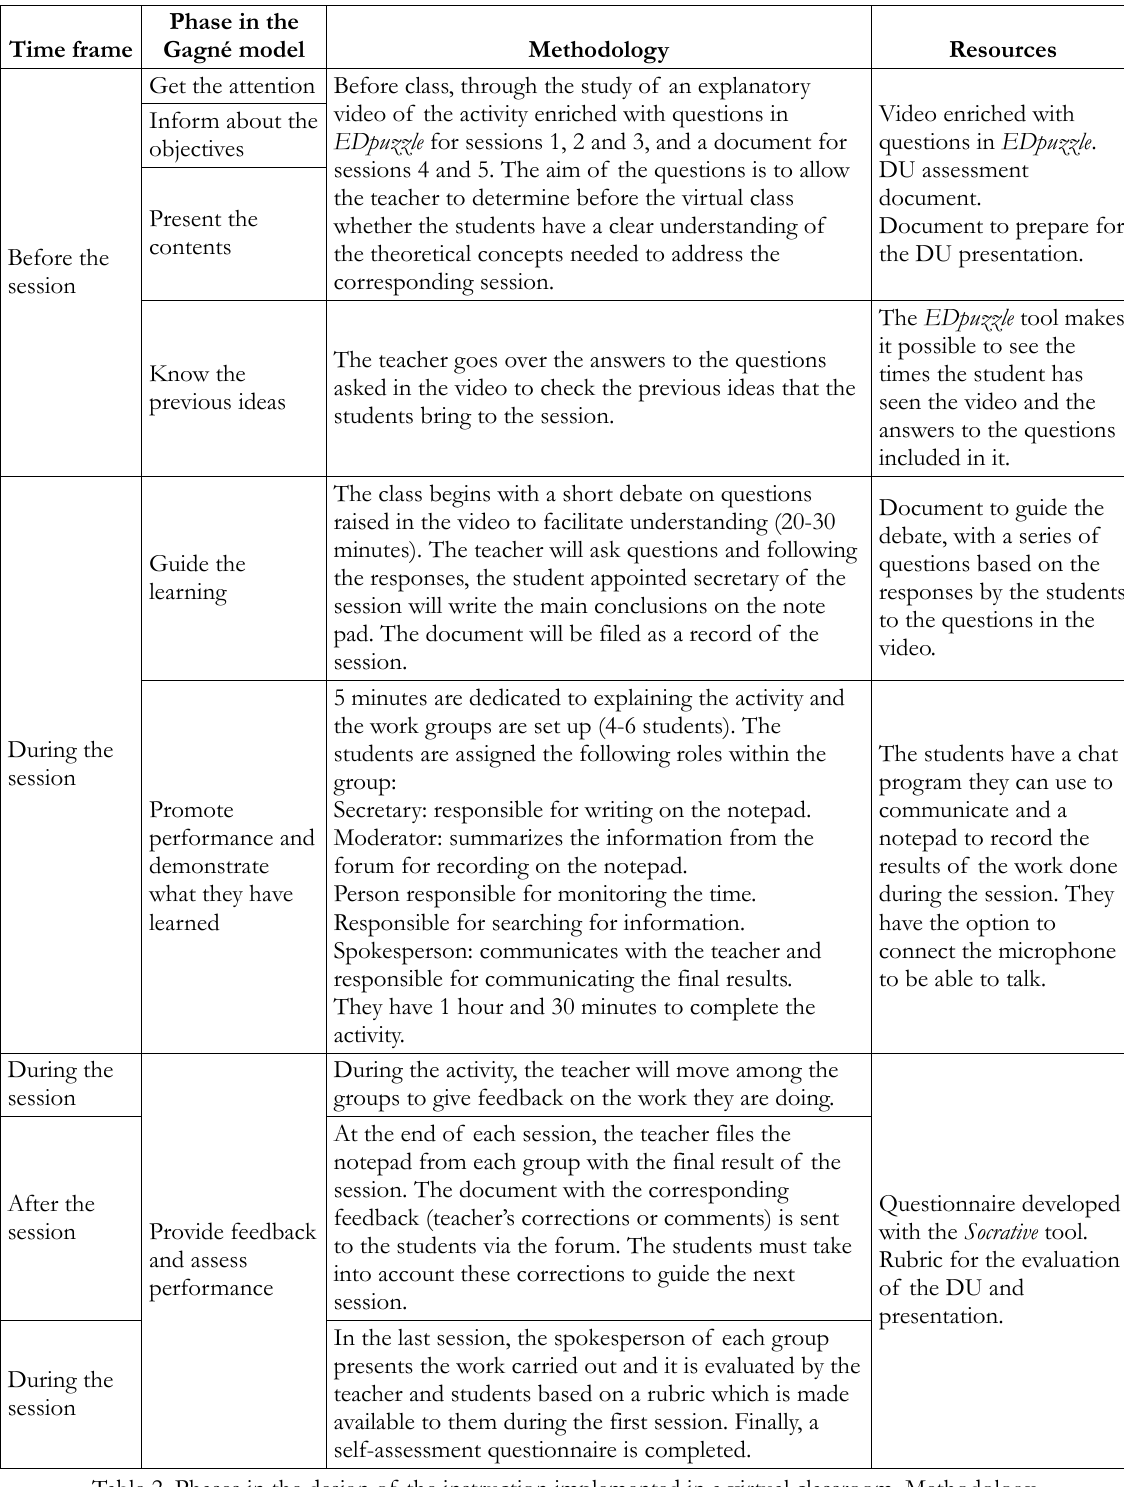
Table 2. Phases in the design of the instruction implemented in a virtual classroom.